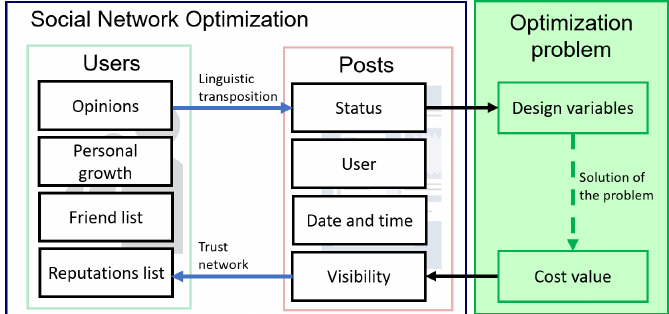
Figure 3. Internal structures of social network optimization and their relation to the optimization